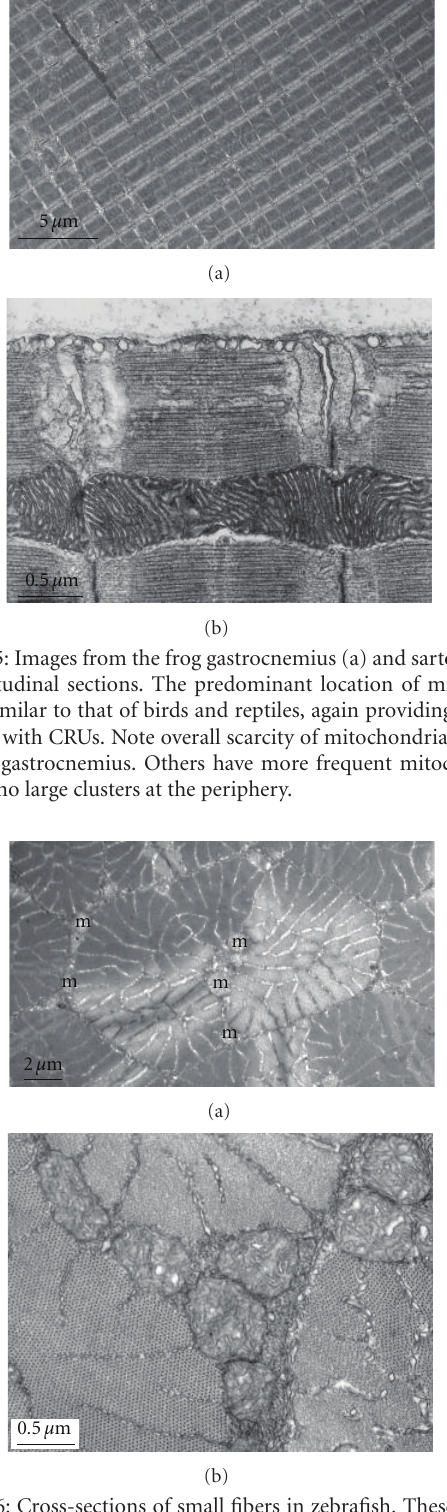
Figure 6: Cross-sections of small fibers in zebrafish. These images illustrate two characteristics of mitochondria (m) disposition in fish muscles. There is a tendency for clustering of the organelles in small groups that are mostly segregated to the fibers’ edges. In this manner, proximity of the mitochondrion’ surface to CRUs is quite